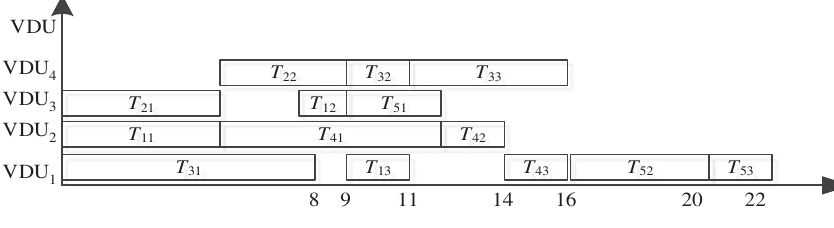
Figure 1: An Initial Allocation.